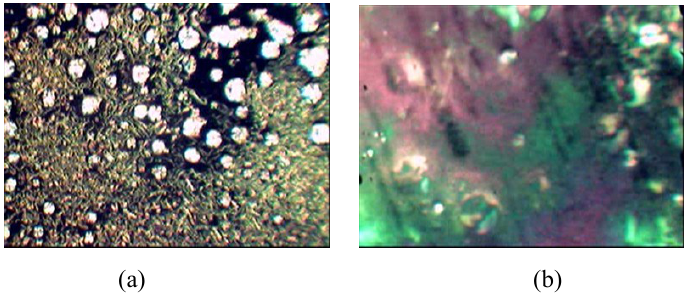
Figure 2. (a) Optical photomicrograph of the filaments texture observed at 230 o C at a cooling rate of 0.1 o C min -1 of the SmA phase developing from the isotropic phase, for compound 6 . (b) Optical photomicrograph of compound 7 exhibiting nematic phase.